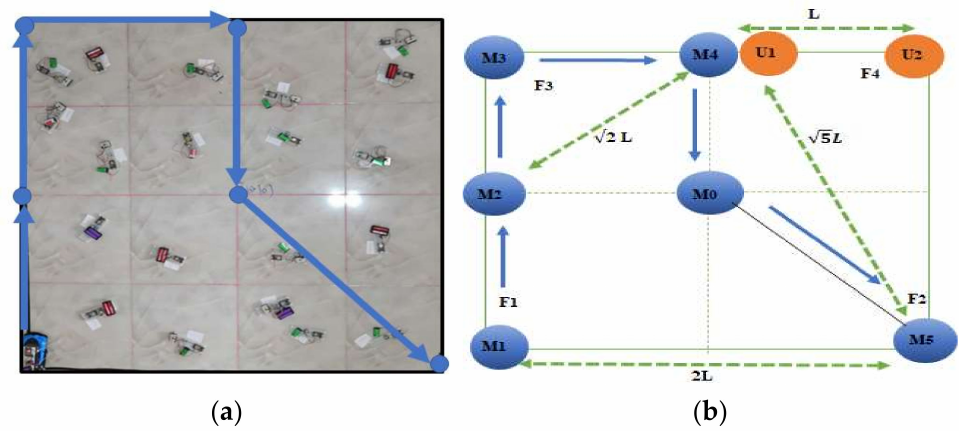
Figure 3. ( a ) Applied R-Curve path model; ( b ) R-Curve path model (le = 1).